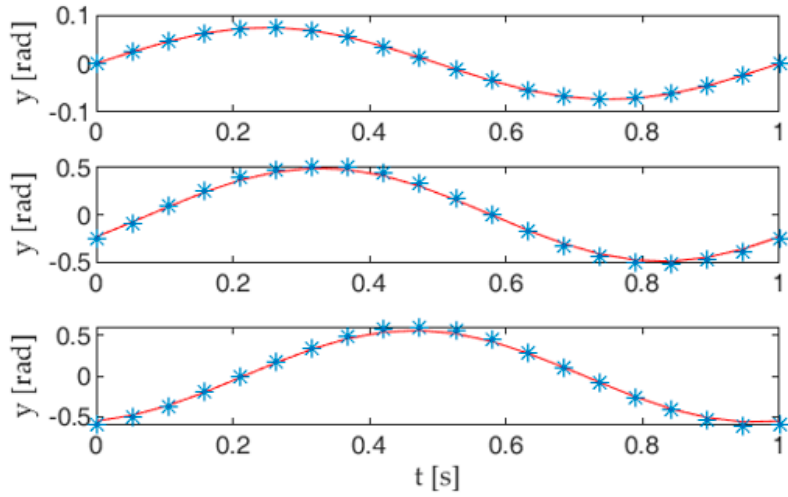
Figure 12. Trends of the absolute angles p j (solid lines) stated by Equation (9) compared to those obtained with the cam joint angles (dotted lines), as shown in (10).